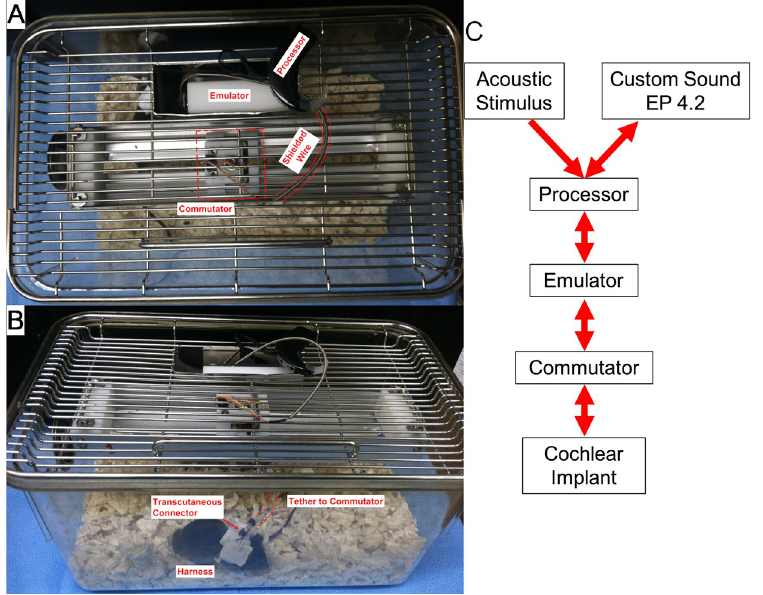
Fig 4. Example of the stimulation cage. (A) Top down view shows the modified cage top with the implant emulator and processor within a metal enclosure. The emulator is connected to a sliding commutator via cabling protected by a spring-shield. The commutator is connected via a short length of cable which tethers to a transcutaneous connector in the electrode array assembly, which is stabilized by a harness (B). The translating commutator allows free movement of the mouse throughout the entire caging system, while maintaining electrical connectivity. (C) Diagram of the connectivity of the system with arrows denoting the direction of stimulus or recording flow.